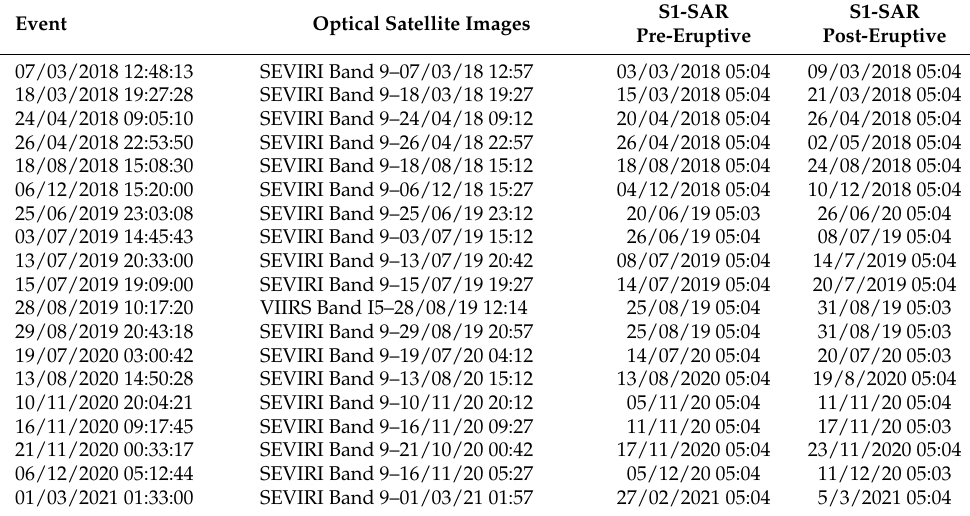
Table 2. Optical and Radar satellite images used for each investigated volcanic explosion. Date and time in dd/mm/yyyy hh:mm:ss format. Time is expressed in UTC. Event Optical Satellite Images